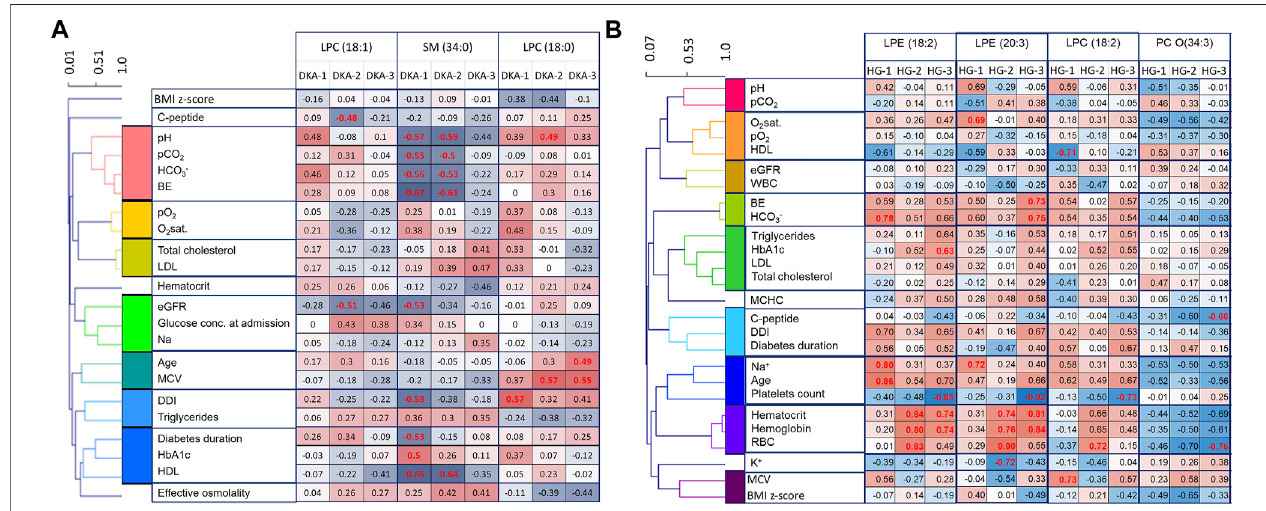
FIGURE 4 | Clinical features correlations with DKA markers (A) and for HG markers (B) . In order to ease the data interpretation, clinical features were clustered based on Pearson ’ s correlation coef fi cient. Signi fi cant correlation coef fi cients are